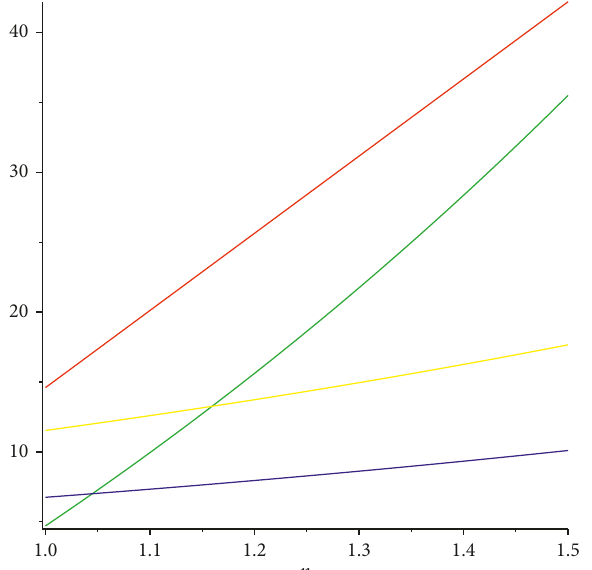
Figure 12: IRB of D